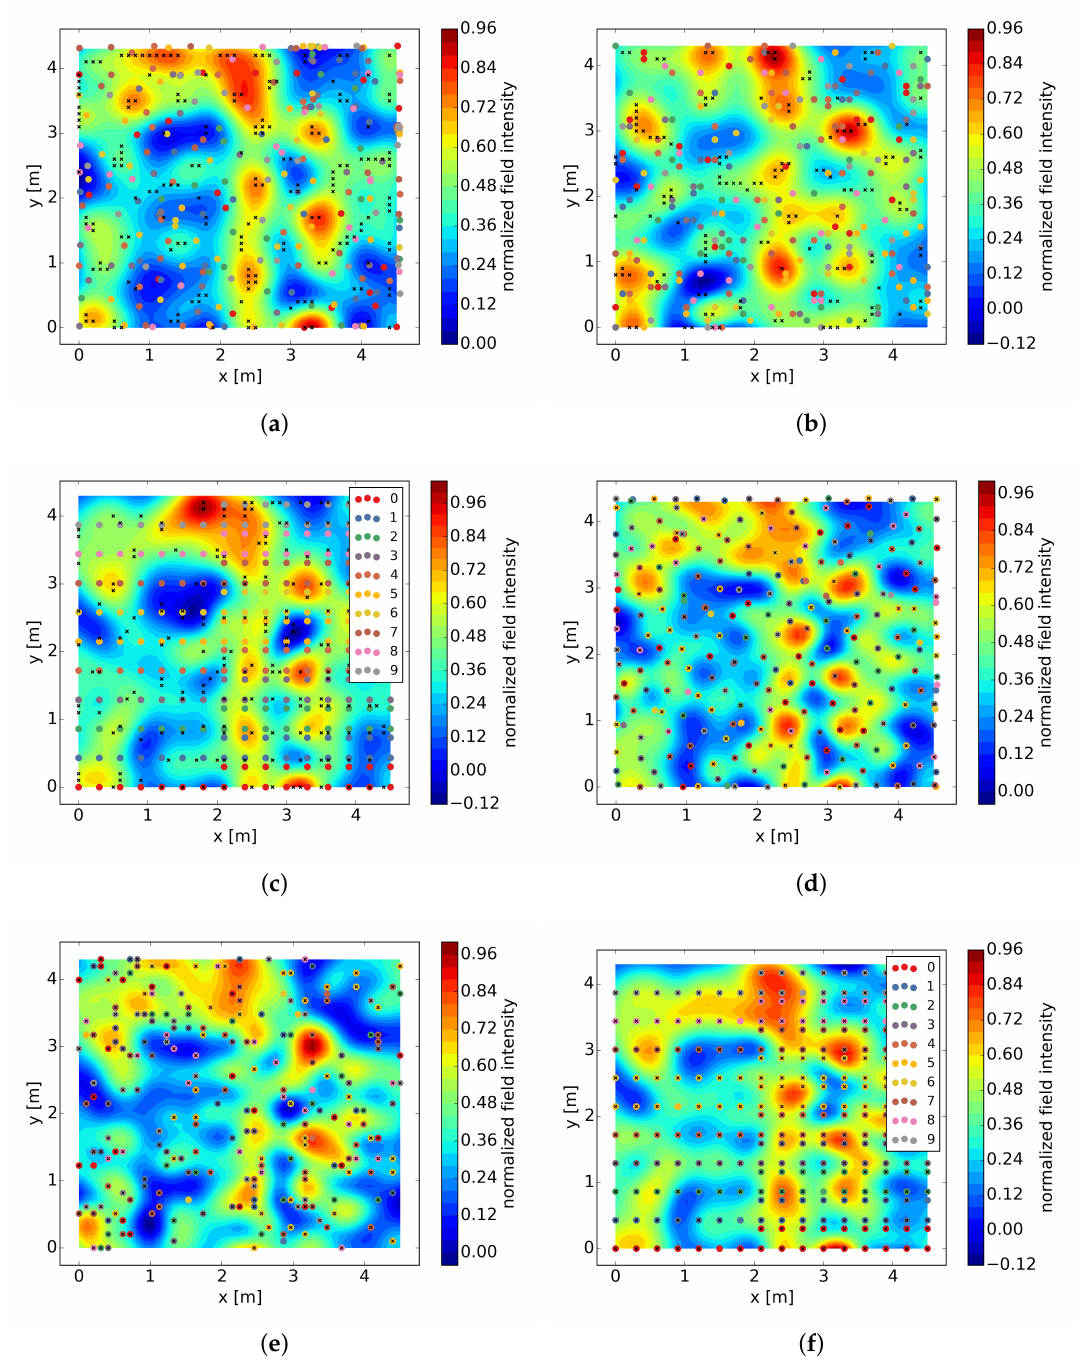
Figure 4. Estimation results for a single run of the estimation algorithm with the SOF and SOE splitting approaches. The measurement positions of the individual agents are marked with colored circles. The active features are marked by with black crosses. ( a – c ) show the estimations of an SOE approach, and ( d – e ) show the estimations of an SOF approach. ( a ) SOE estimation with entropy-driven exploration ( b ) SOE estimation with random exploration strategy; ( c ) SOE estimation with meander exploration strategy; ( d ) SOF estimation with entropy-driven exploration; ( e ) SOF estimation with random exploration strategy; ( f ) SOF estimation with meander exploration